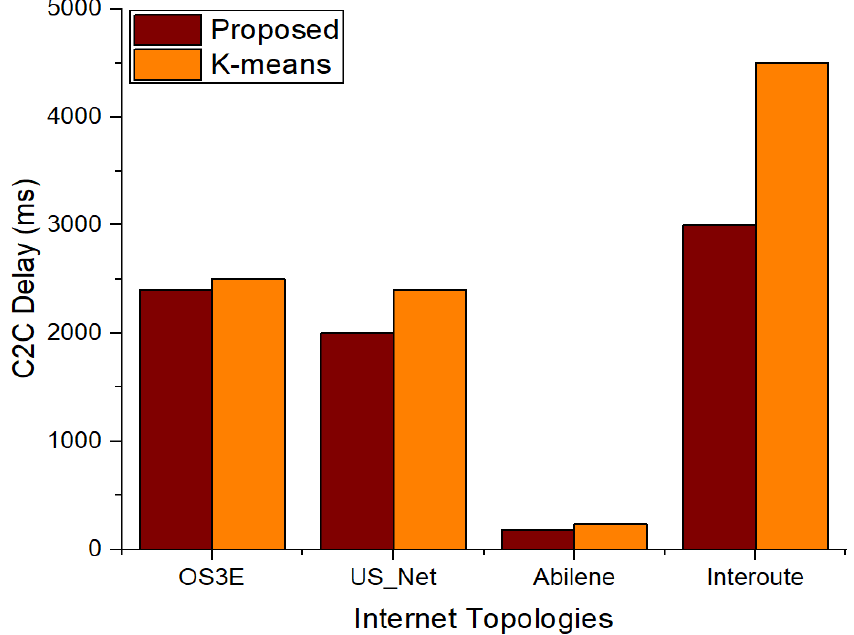
Figure 9. Comparison of C2C delay between proposed scheme and k-means with 7 clusters.